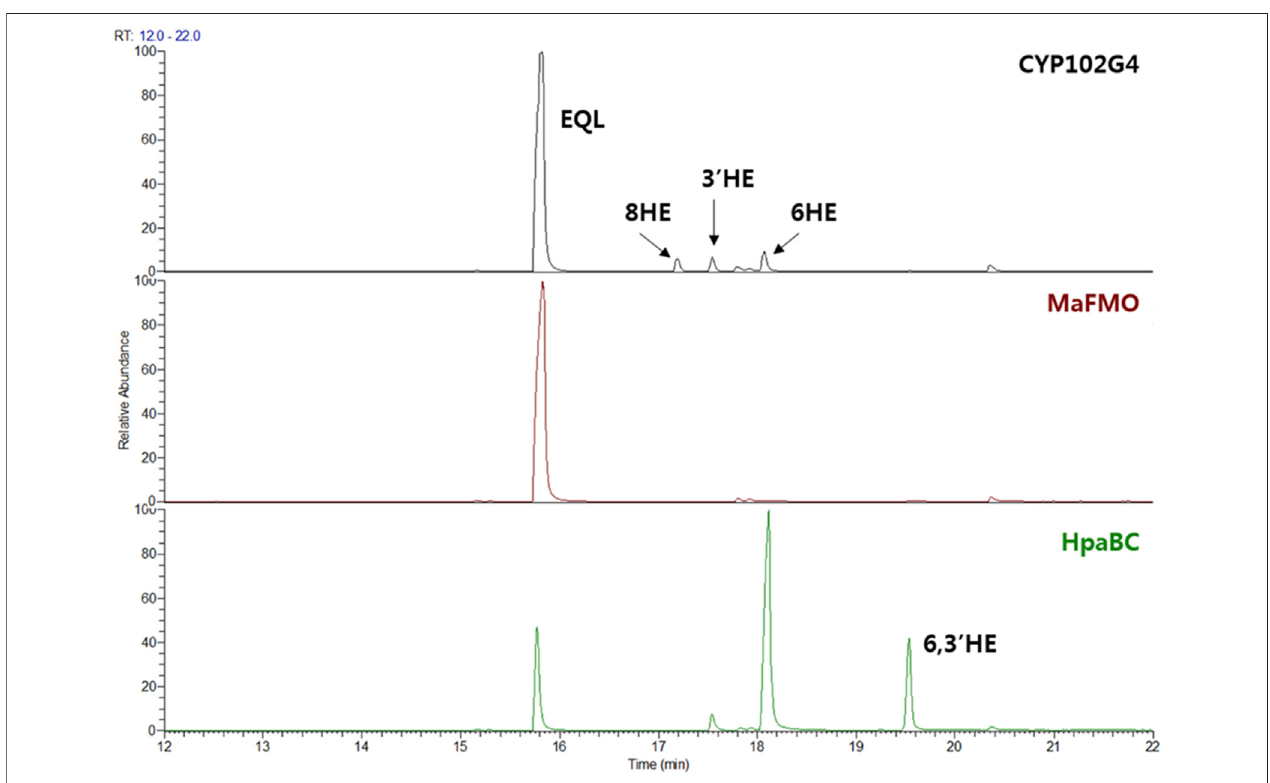
FIGURE 2 | ( S )-equol (EQL) monooxygenation assay using whole-cells expressing three microbial monooxygenases: CYP102G4, Ma FMO, and Ec HpaBC. 200 μ M of ( S )-equol was initially used for the whole-cell (OD 600 = 10) biotransformation, and reaction extracts at 4 h were analyzed using GC-MS.